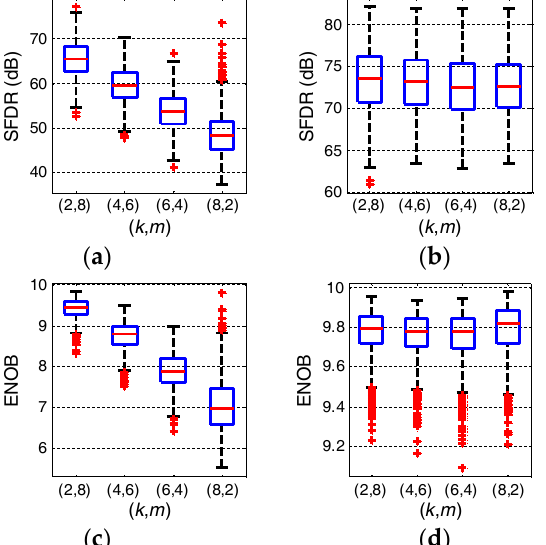
Figure 8. With the different matching accuracy among the resistor units and among the current-source units, the boxplot of spurious-free dynamic range (SFDR) ( a , b ) and the effective number of bits (ENOB) ( c , d ) of a 1000 Monte Carlo MATLAB simulations when k and m vary. In ( a , c ), δ = ξ = 0.02. In ( b , d ), √ √ 2 2 2 k m 4 2 k δ = 2 k + 4 and ξ = 2 2 k + m + 2 , respectively.